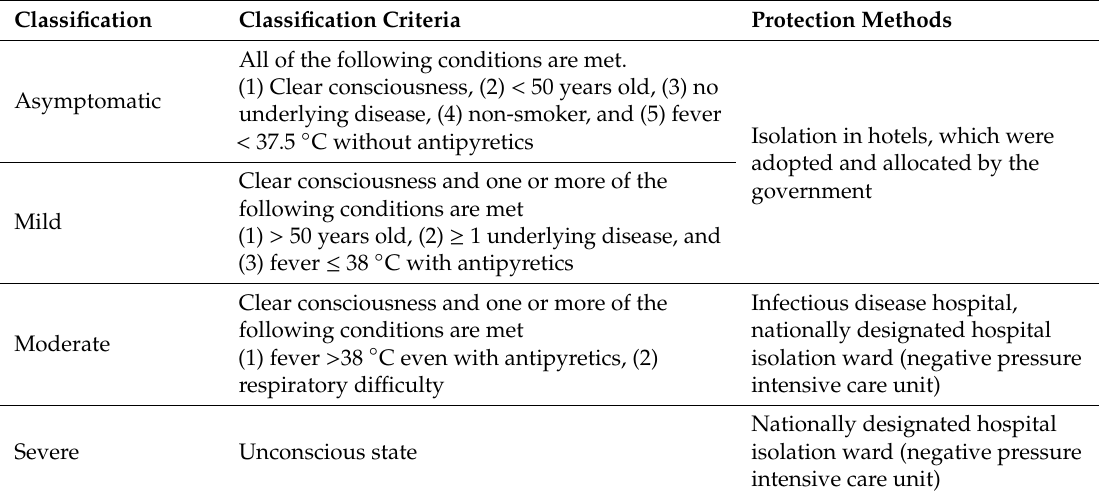
Table 1. Classification of patients with COVID-19 and protection